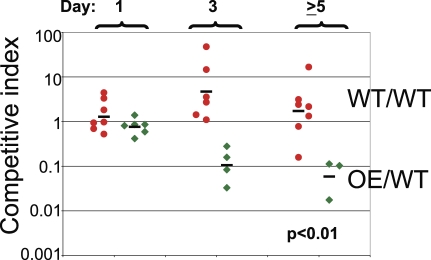

EFH1 Overexpression Reduces Colonization of the Oral Cavity in Immunodeficient MiceCells of strains CKY363 (WT) or CKY364 (EFH1 overexpressing, OE) were mixed in a 1:1 ratio with strain RMIS1 (NouR marked WT) and introduced into the oral cavities of nude mice by swabbing. On various days post-inoculation, the oral cavities were sampled by swabbing. Swabs were rubbed on YPD SA plates and the colonies were replica-plated to YPSnourseothricin to determine the ratio of NouS to NouR colonies. The CI is defined as the ratio of NouS/NouR colonies at time x, divided by their ratio in the inoculum. Each symbol represents a sample taken from an individual animal. Composite results of two experiments are shown. Red circles, CKY363 (WT) mixed with RMIS1 (seven mice); dark green diamonds, CKY364 (EFH1 overexpressing) mixed with RMIS1 (six mice). Day ≥5 includes samples taken at either day 5 or day 6. Samples that yielded very few colonies (<10) were not included on the graph. A statistically significant difference (p < 0.01 by t test) was observed at day ≥5.